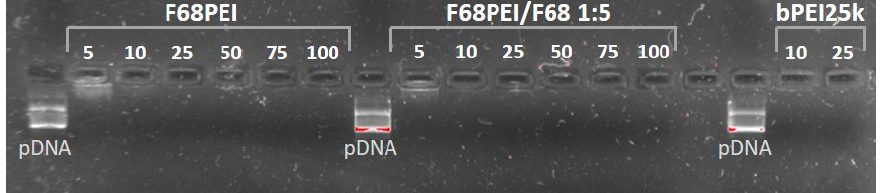
Figure 3. DNA complexation ability of F68PEI without and with the addition of free F68 (1:5 w/w ) determined by agarose gel electrophoresis. For F68PEI and F68PEI/F68 1:5, N/P ratios between 5 and 100 were tested. For the control bPEI25k N/P ratios between 10 and 25 were tested.